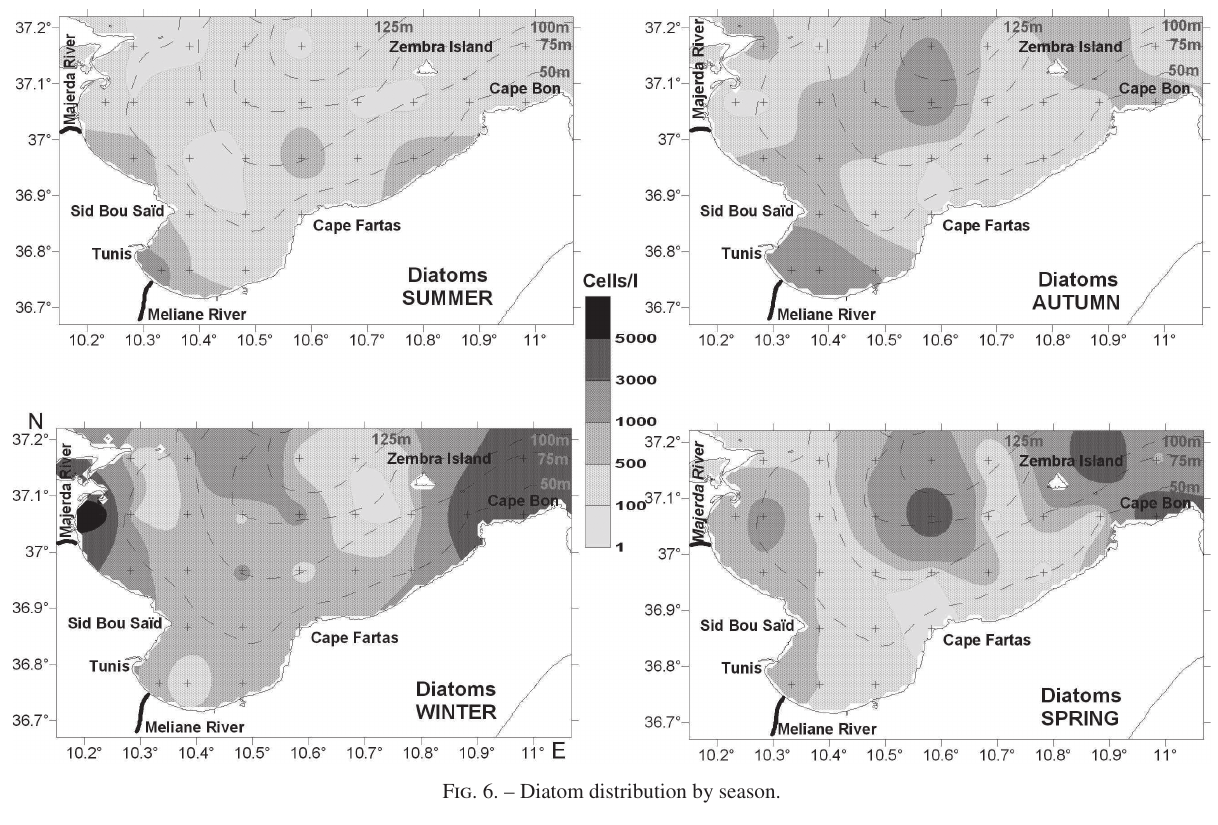
Fig. 6. – diatom distribution by season.